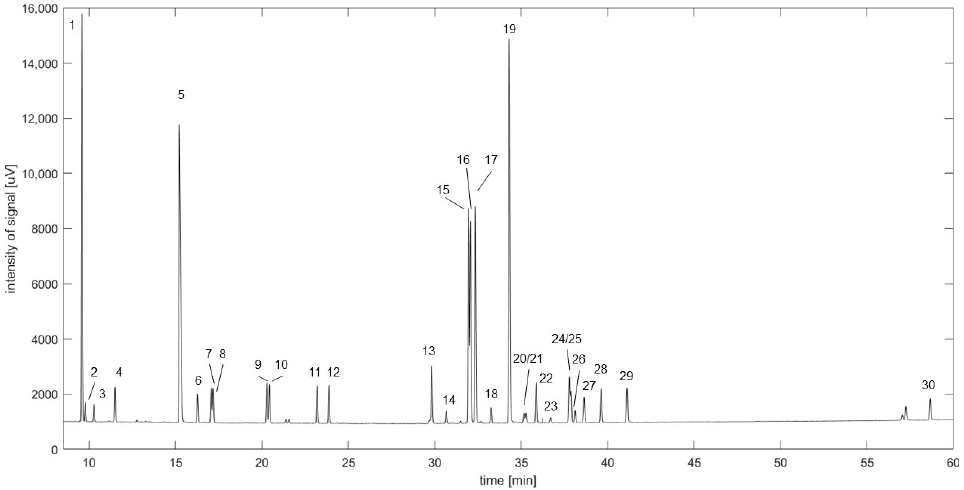
Figure 2. Chromatogram for the analysis of 30 rose oil components on the chiral column. Table 2. Retention times and results for the validation of 30 rose oil compounds analysed on the chiral column with GC-FID.